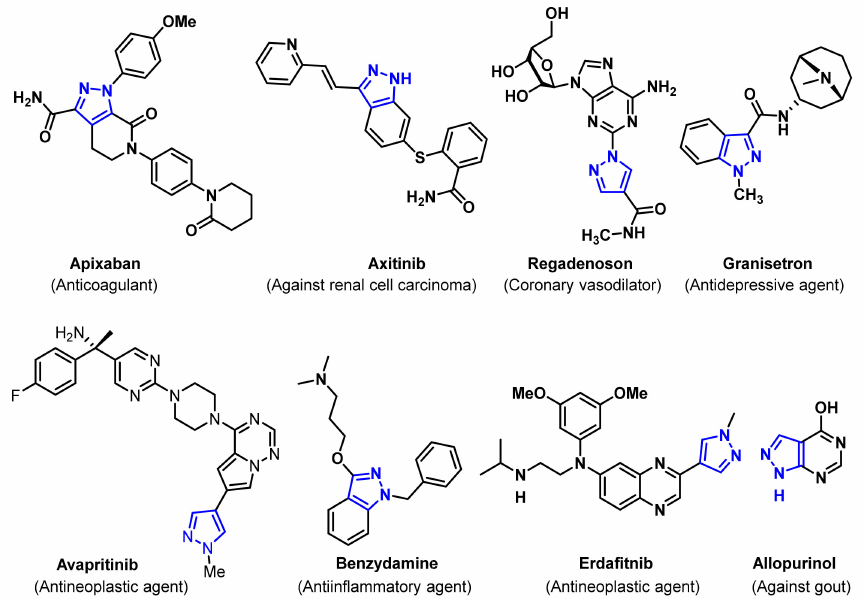
Figure 1. Representative FDA-approved pyrazole-containing medicines. FDA: U.S. Food and Drug